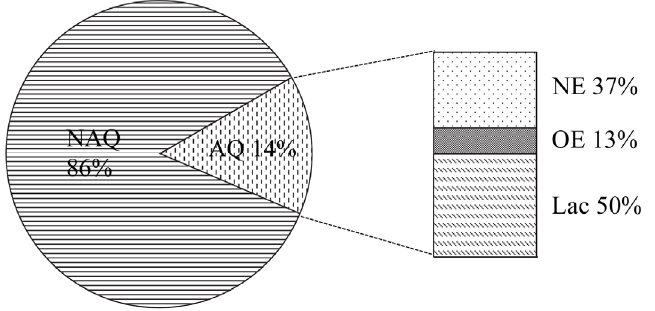
Figure 2. The relative abundance of phyllosphere bacteria capable of interfering AHL with different characteristics. Abbreviations: NAQ, non-AHL quencher; AQ, AHL-quencher; NE, AHL-inhibitor based on non-enzymatical interference type; OE, QQ strains degrade AHL by other quenching enzyme; Lac, QQ strains degrade AHL by